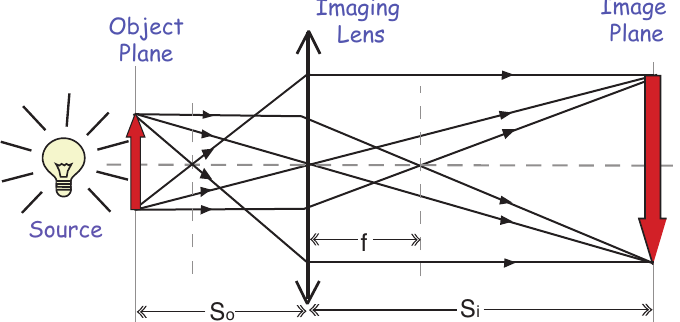
Figure 1. Optical imaging: a lens produces an image of an object in the plane defined by the Gaussian thin-lens equation 1/ s i + 1/ s o = 1/ f . Image formation is based on a point-to-point relationship between the object plane and the image plane. All radiation emitted from a point on the object plane will “collapse” to a unique point on the image